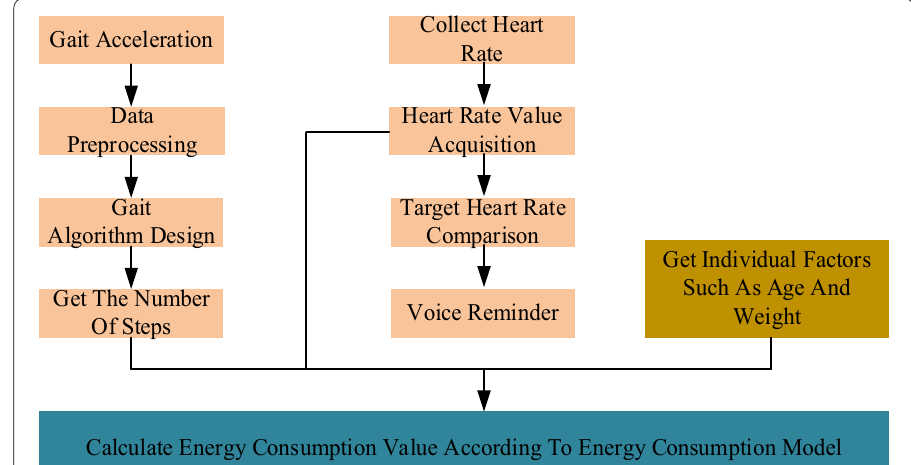
Fig. 3 Frame diagram of running training assistive technology system